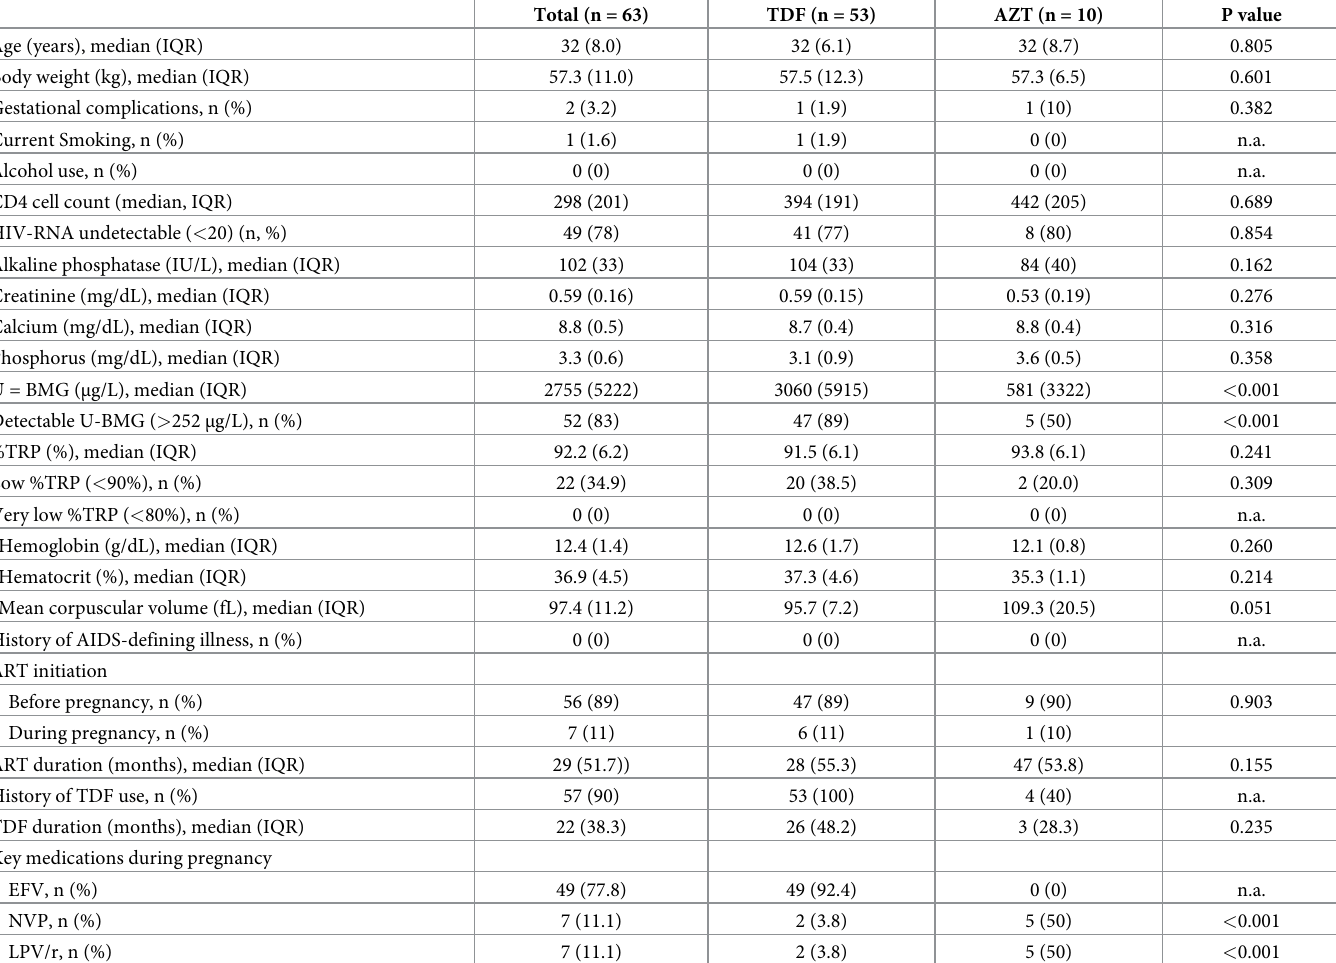
Table 1. Clinical characteristics and laboratory test results of pregnant women at 32–36 weeks of